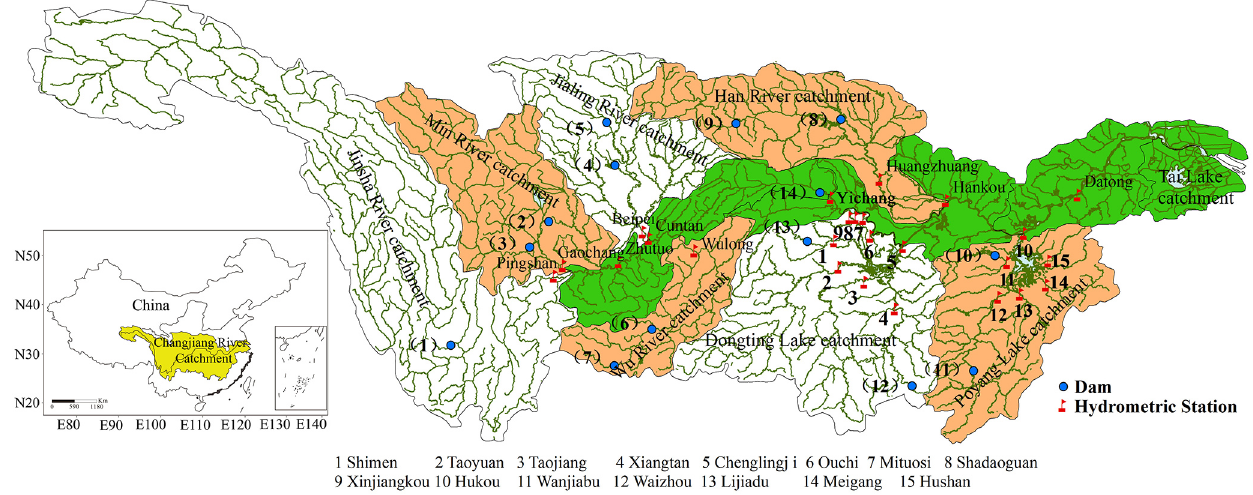
Figure 1. The Changjiang catchment and location of the hydrologic stations for the Changjiang catchment. The numeric symbols in the figure denote some important reservoir sites, including (1) Er’tan, (2) Heilongtan, (3) Tongjiezi, (4) Shengzhong, (5) Baozhushi, (6) Wujiangdu, (7) Puding, (8) Danjiangkou, (9) Ankang, (10) Zhelin, (11) Wan’an, (12) Dongjiang, (13) Jiangya and (14) Three Gorges